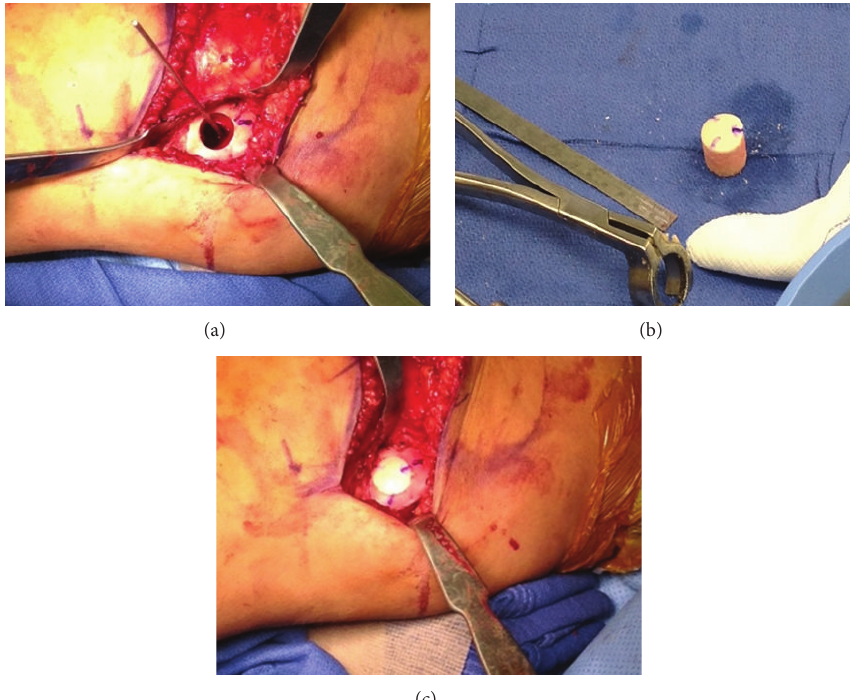
Figure 5: Intraoperative photographs showing marginal excision and preparation of medial femoral condyle (a), osteochondral allograft preparation (b), and implantation (c).